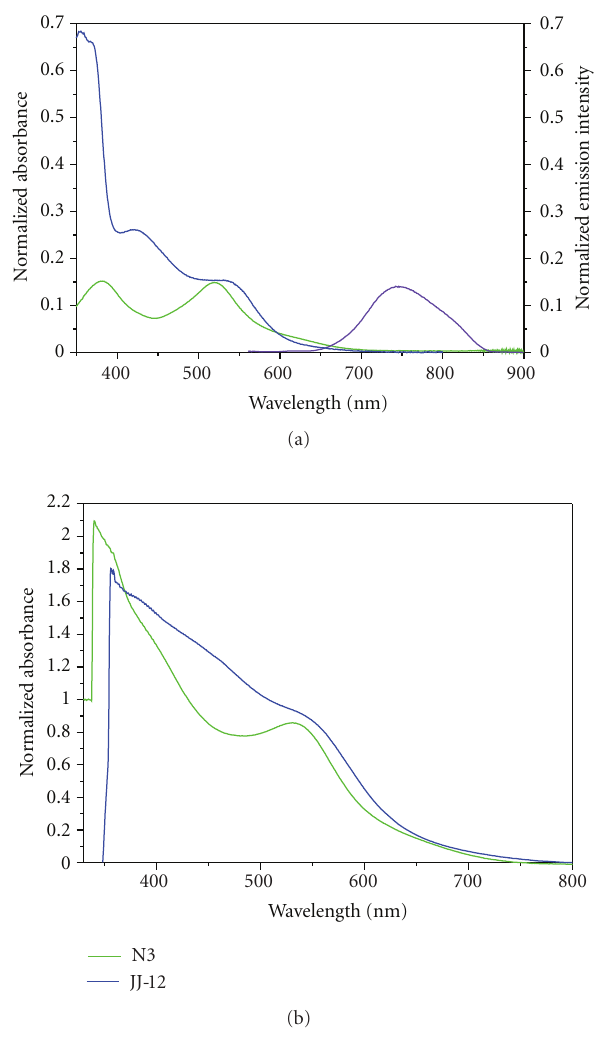
Figure 2: Absorption and emission spectra (a) of JJ-12 (blue line) and N3 (green line) in EtOH, and absorption spectra (b) of JJ-12 (blue line) and N3 (green line) adsorbed on TiO 2